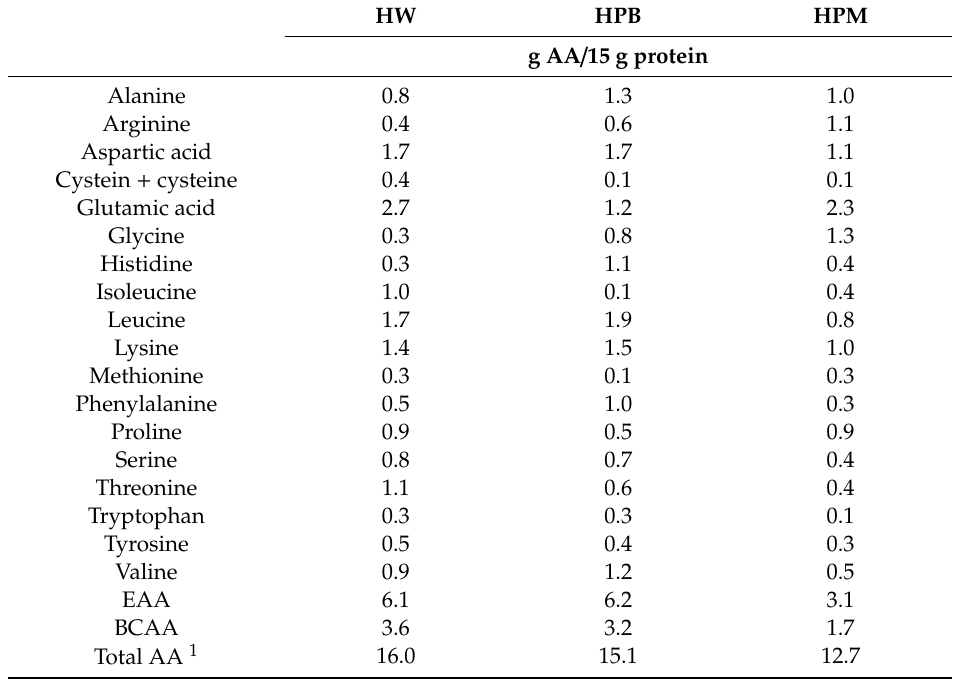
Table 1. Amino acid (AA) composition in 15 g